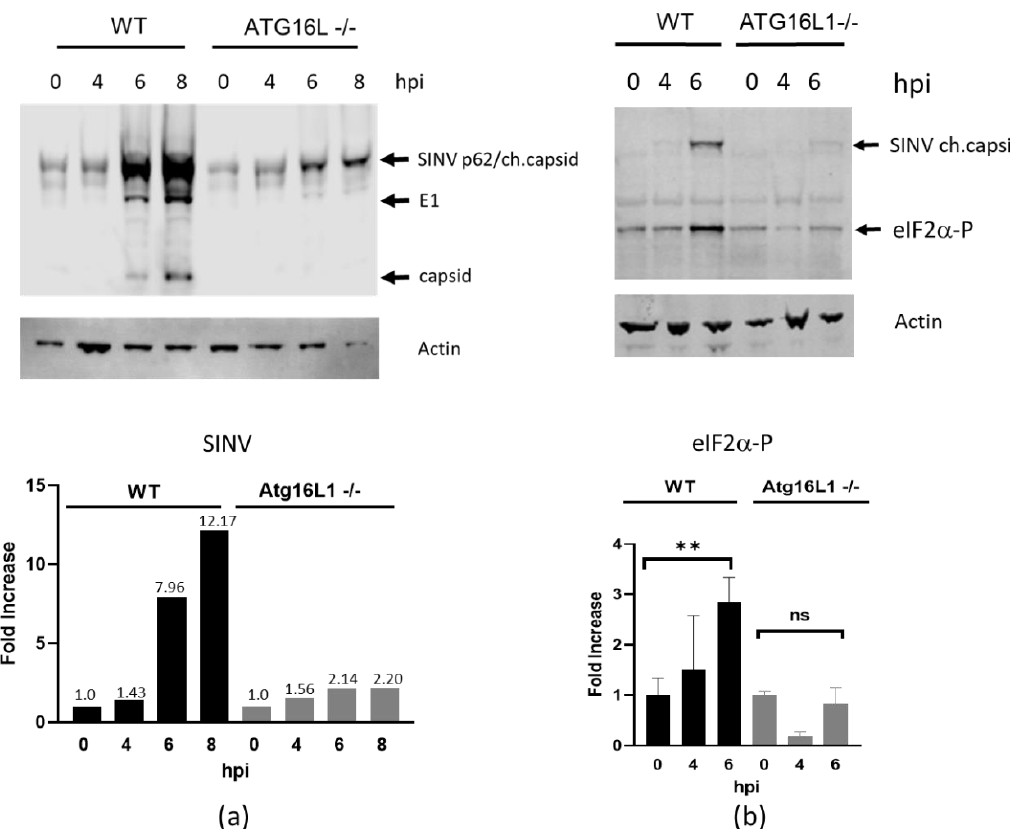
Figure 1. eIF2 α phosphorylation and virus protein production is diminished in ATG16L1- / - cells. ( a ) Western blot of SINV-infected lysates at 0–8 hpi detected with anti-SINV antibody. Bar chart below shows fold increase in p62 / capsid proteins relative to actin. ( b ) SINV expressing cherry capsid detected with anti-dsRred antibody and phosphorylated eIF2 α detected with rabbit monoclonal phospho-eIF2 α (Ser51). Bar chart below shows the fold increase in eIF2 α -P normalised to actin for 3 independent blots with +/ -SE ** p < 0.01, ns is non-significant.